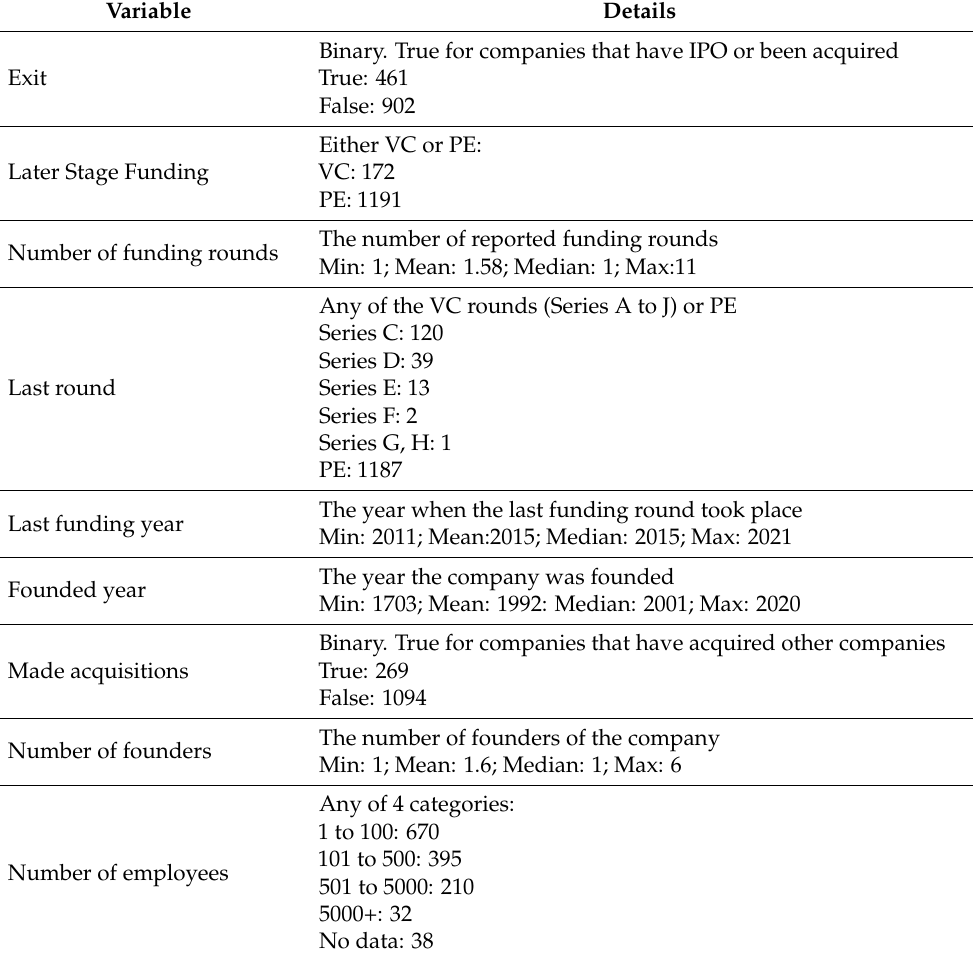
Table 2. Variables Used in the